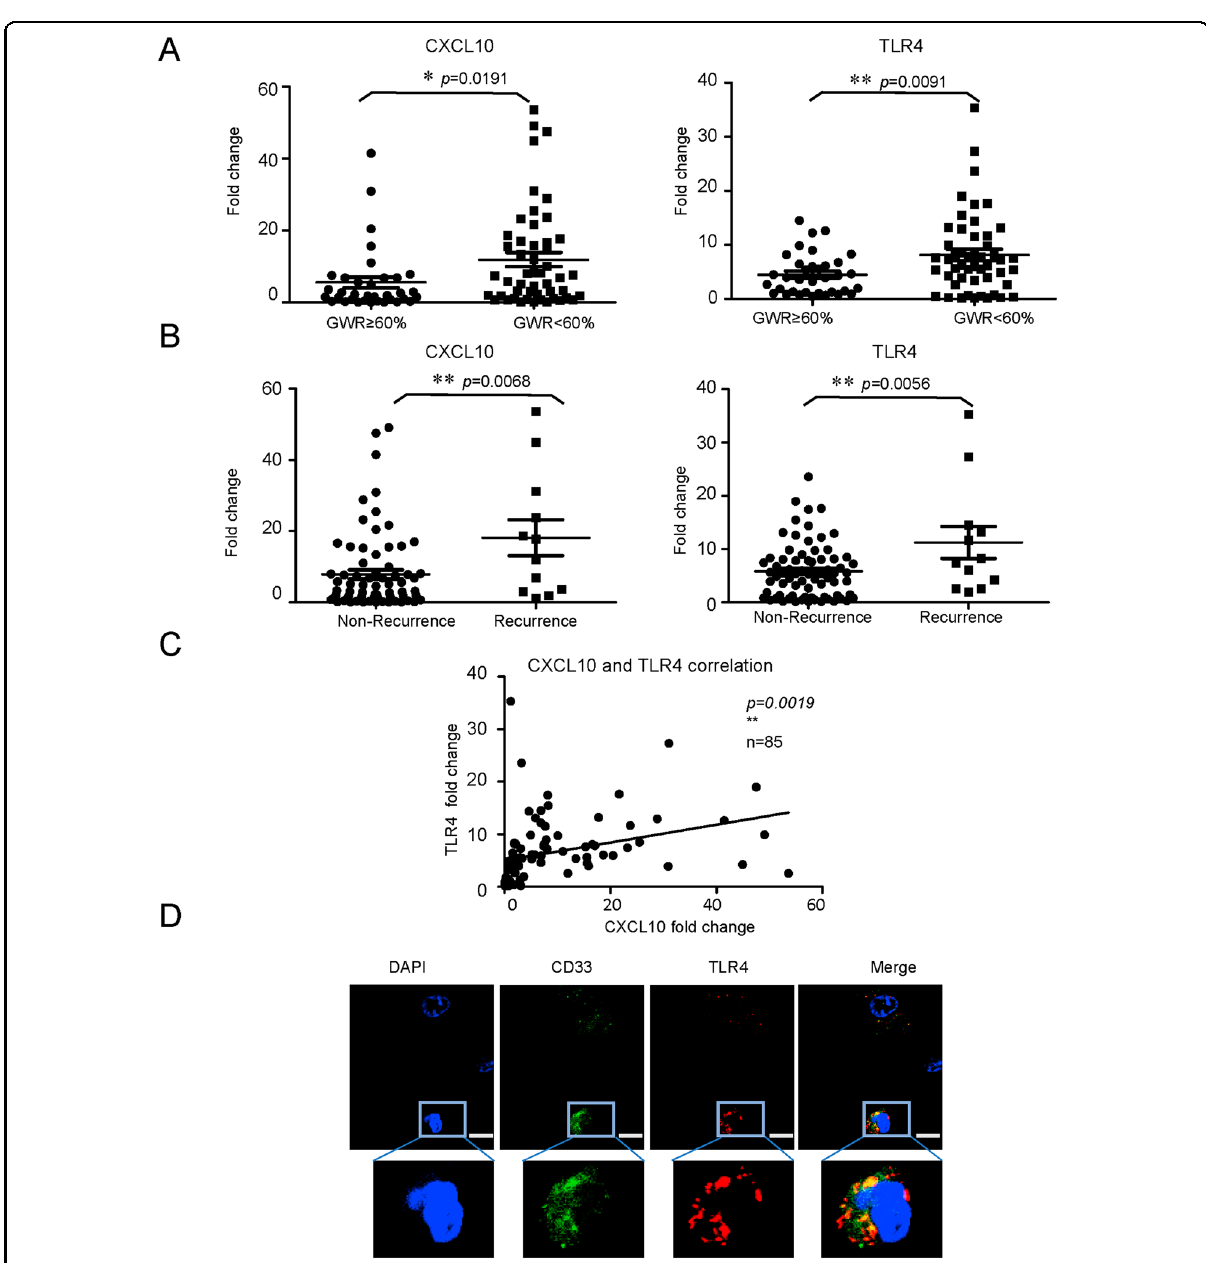
Fig. 2 Association of higher CXCL10/TLR4 levels in small-for-size graft with tumor recurrence in HCC patients after transplantation. Intragraft CXCL10 and TLR4 expressions were examined at hour 2 after liver transplantation. A Enhanced expression of CXCL10 and TLR4 in patients who received small-for-size liver grafts (GWR < 60%) compared to large liver grafts (GWR ≥ 60%) ( n = 85). B Higher levels of CXCL10 and TLR4 in the recipients with HCC recurrence than non-recurrent patients ( n = 85). C The signi fi cant positive correlation between intragraft CXCL10 and TLR4 expression ( n = 85). D Co-localization of TLR4 and MDSC (CD33 positive) in liver graft post-transplantation (a representative from three times independent experiments). Scale bars: 5 μ m. Error bars indicate standard error of mean; *p < 0.05, ** p < 0.01. HCC hepatocellular carcinoma, MDSC myeloid-derived suppressor cell, GWR graft weight